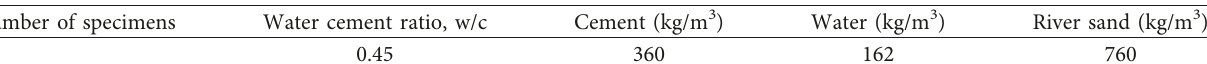
Table 2: Cement mortar mixture scheme.